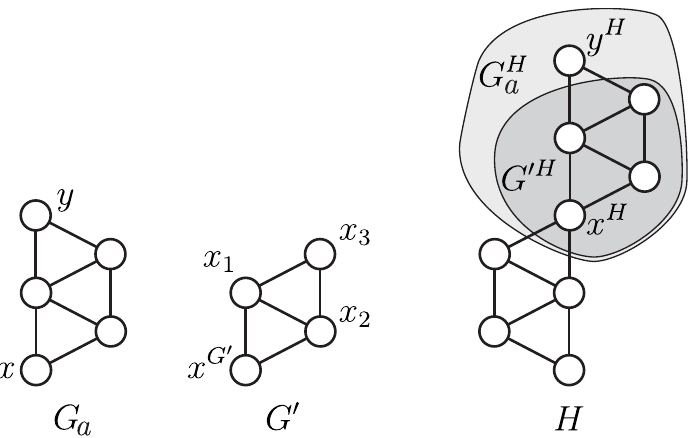
Fig 3. Reducing the k -node graphlet G a to a k − 1 node graphlet G 0 . O 59 appearsin G a = G 24 ; the nodein O 59 is labelled x . Removal of node y results in G 0 = G 7 . The node in G 0 that corresponds to x , x G 0 , belongsto O 12 . We assignedlabels x 1 , x 2 and x 3 to the remainingnodesof G 0 . Embeddings of G a and G 0 in H are referred to as G H and G 0 H , respectively.The nodescorresponding to x and y are marked by x H and y H . a